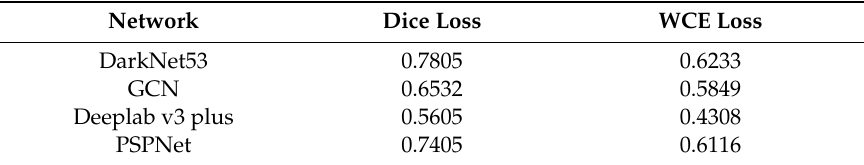
Table 4. Results of door segmentation with R-FP datasets.